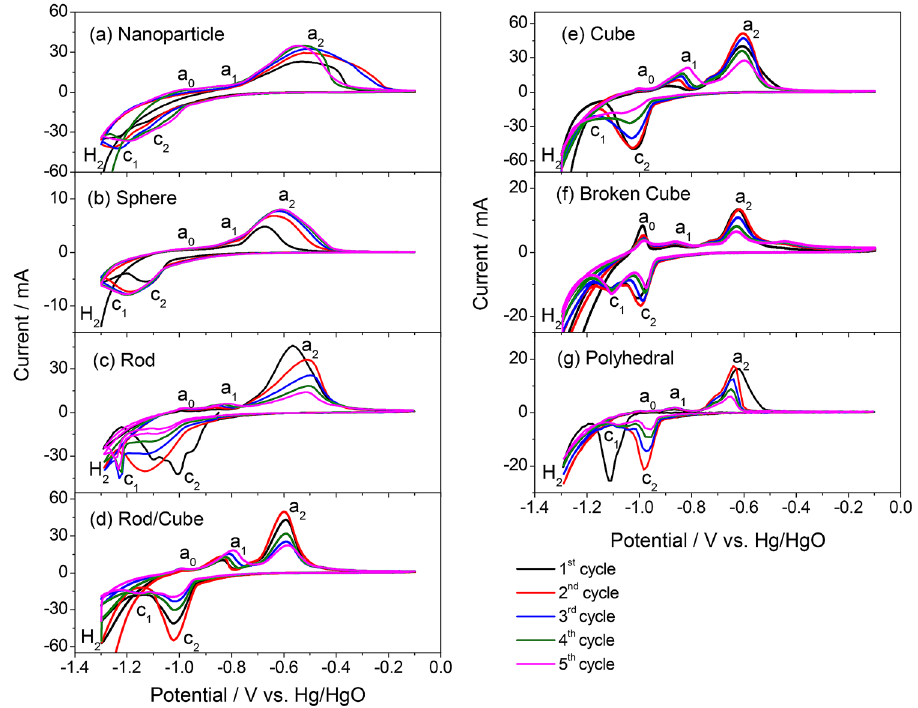
Figure 3. CVs of Fe 2 O 3 /AB electrodes with various morphologies of Fe 2 O 3 synthesized via hydrothermal route in KOH solution: ( a ) nanoparticle, ( b ) sphere, ( c ) rod, ( d ) rod/cube, ( e ) cube, ( f ) broken cube, and ( g )